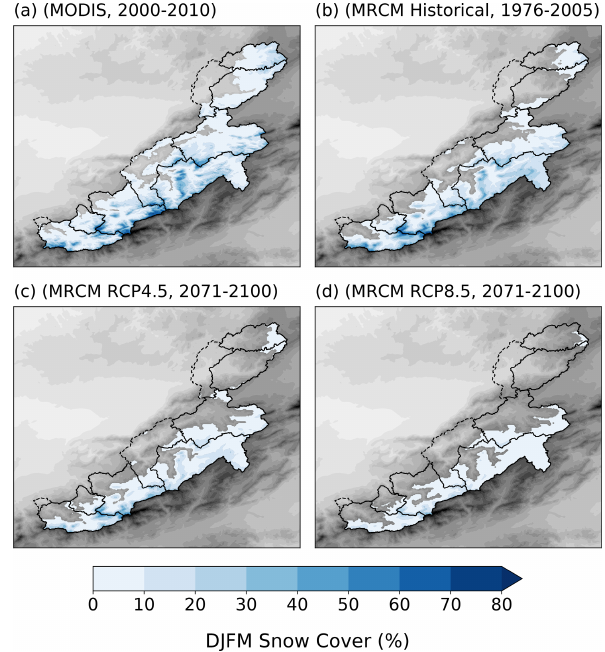
Figure 5. Annual cycles of snow cover (in %) in the MODIS obser- vations (2000–2011; black), ERA- Interim simulation (2000–2011; dashed red) and three GCM-driven historical simulations (1994– 2005; solid blue: median; blue shading: three-model range), at various elevations ranges within our study area: (a) > 3500m, (b) 3000–3500m, (c) 2500–3000m, (d) 2000–2500m, (e) 1500– 2000m and (f) the whole area.